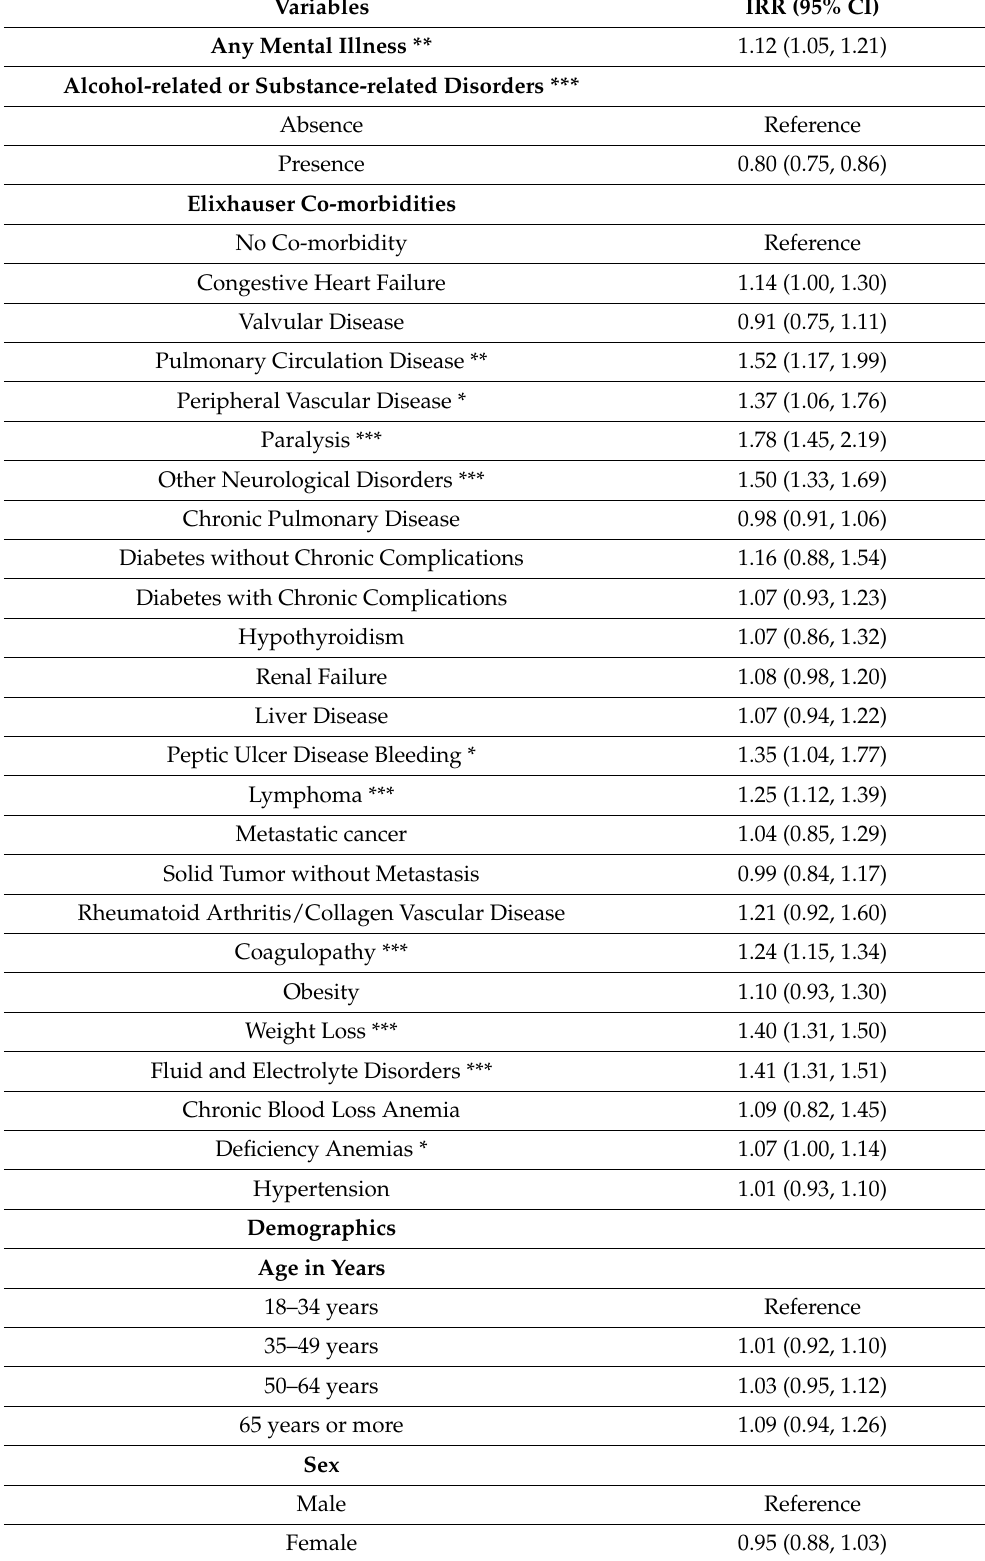
Table 3. Impact of secondary mental illness on hospital length of stay (LOS) among primary HIV discharges in the United